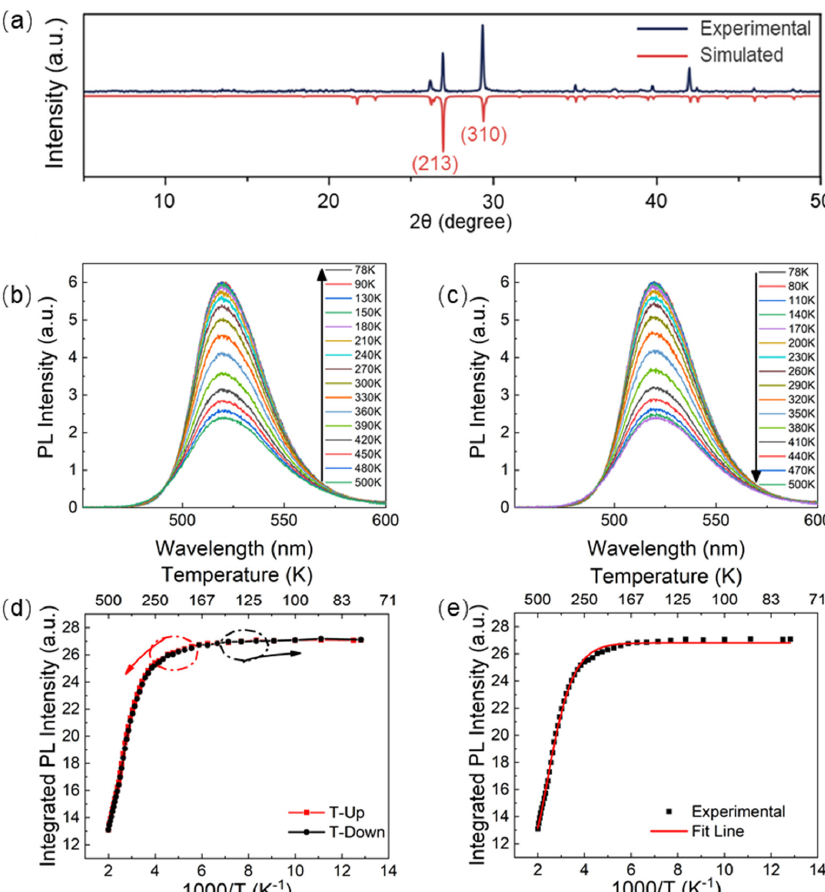
4 ]BrCs 3 film. Figure 1. TGA of anti-perovskite [MnBr